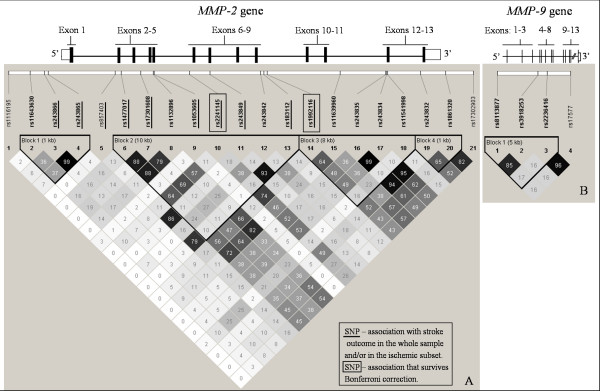
Schematic diagrams of the MMP-2 (A) and MMP-9 (B) genes showing the location of the 13 exons (black boxes), the 5' and 3' untranslated regions (white boxes) and the pairwise r2 plots for the 21 genotyped SNPs in MMP-2 and 4 genotyped SNPs in MMP-9, in our population sample. Markers associated with three months outcome are indicated. Linkage disequilibrium blocks were generated using the Gabriel et al. [19] method.